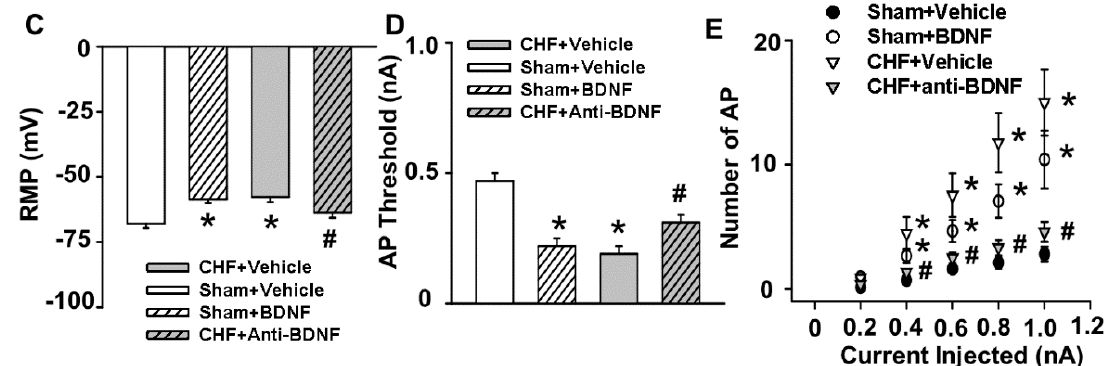
Figure 2. Original tracings ( A , B ) and mean data ( C – E ) showing the effect of 4–6 h incubation of BDNF and anti-BDNF on action potential properties in response to current injection with either an ramp injection protocol (0–1.0 nA, 1.0 sec) or a step injection protocol (200 pA/step, 0–1 nA, 1.0 sec) in the IB4-negative medium-sized muscle afferent DRG neurons from sham + vehicle, sham + BDNF (100 ng/mL), CHF + vehicle and CHF + anti-BDNF (10 µ g/mL) groups. Mean ± SE. n = 13–16 neurons from 6–8 rats/each group. * p < 0.05 vs. sham. # p < 0.05 vs. CHF + Vehicle. AP, action potential. MP, membrane potential; RMP, rest membrane potential.